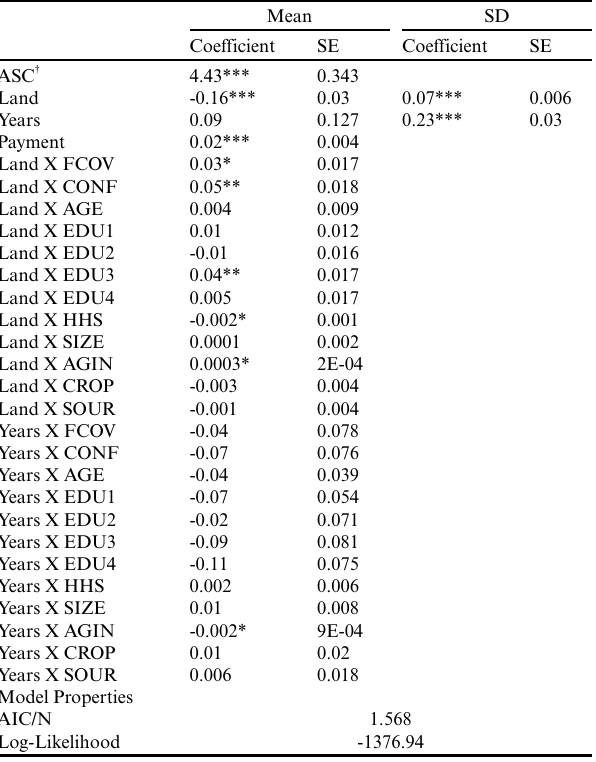
Table 4. Estimated beta coefficients for a random parameter logit (RPL) with interaction variables. We allowed Land and Year to be normally distributed random variables. We also included fixed parameters in the model that interacted Land and Year with the demographic and economic characteristics of respondents from choice experiment surveys conducted in the buffer area of Pench Tiger Reserve, India in 2018–2019. The sign of the coefficients indicates the correlation between program attributes and landowner characteristics. Estimates are from the best-fit model based on AIC.